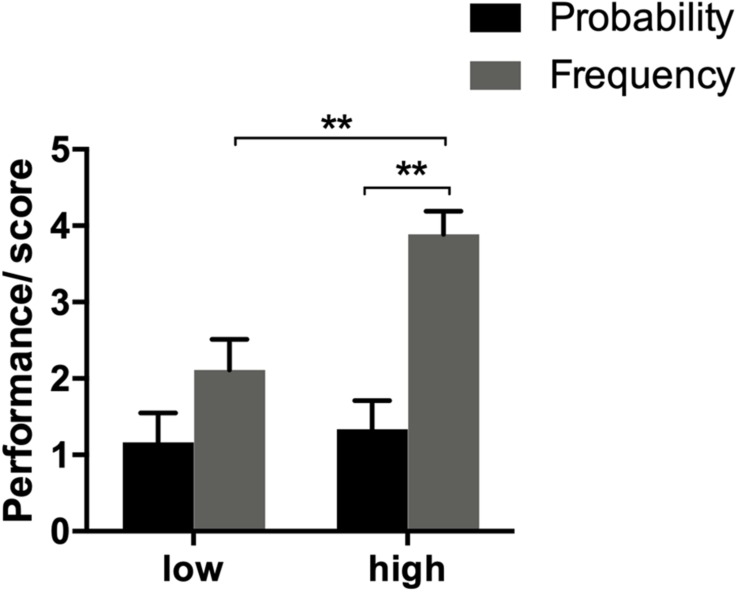
Results of different WMS subjects. ∗p < 0.05 and ∗∗p < 0.01.